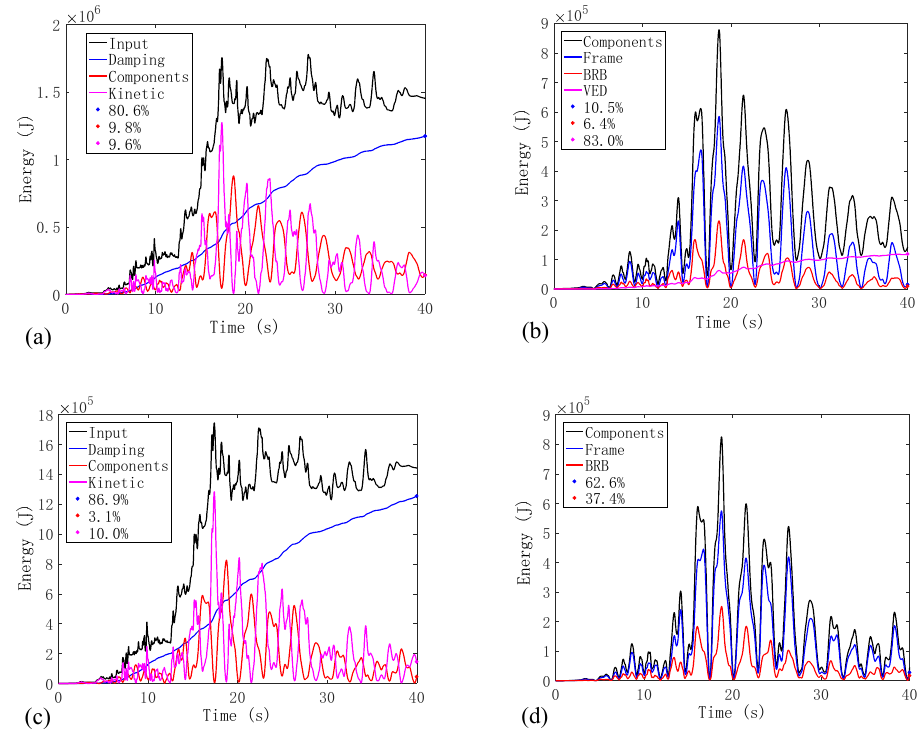
Figure 11. Seismic energy analysis (Imperial Valley-06 case, PGA = 70 cm/s 2 ): ( a ) energy distribution (VBRB-BF); ( b ) energy absorbed by components (VBRB-BF); ( c ) energy distribution (BRB-BF); and ( d ) energy absorbed by components (BRB-BF).